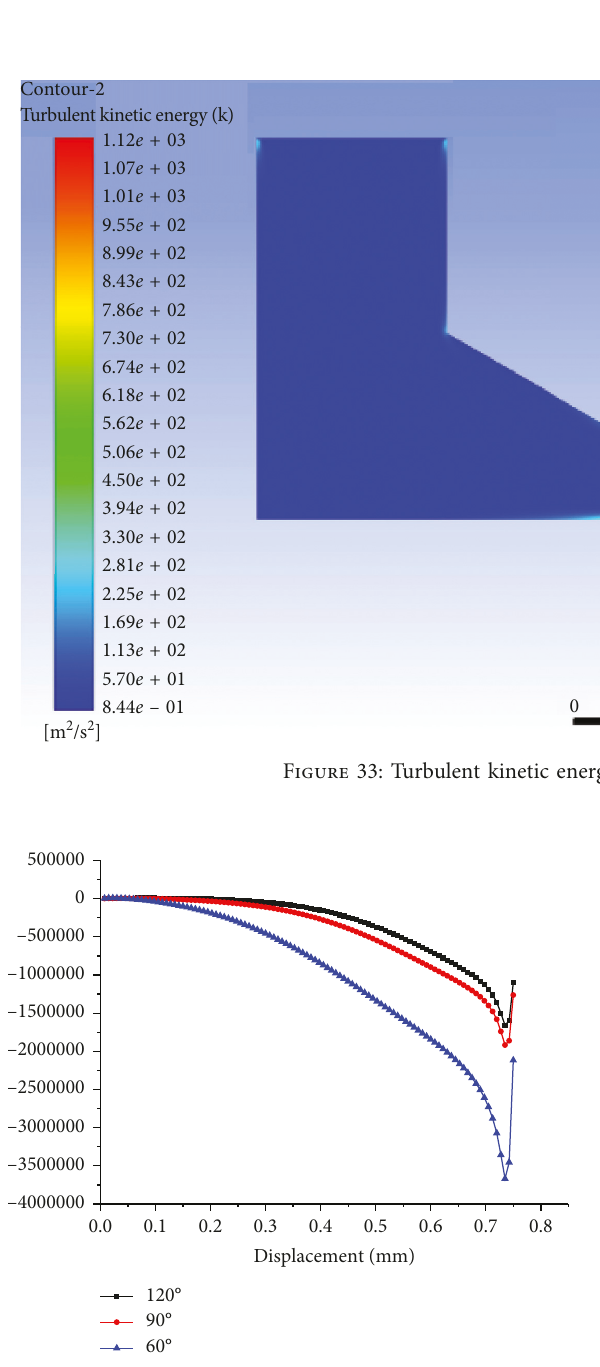
Figure 34: Pressure distribution on the wall of poppet valve port. Figure 35: Velocity distribution at poppet valve